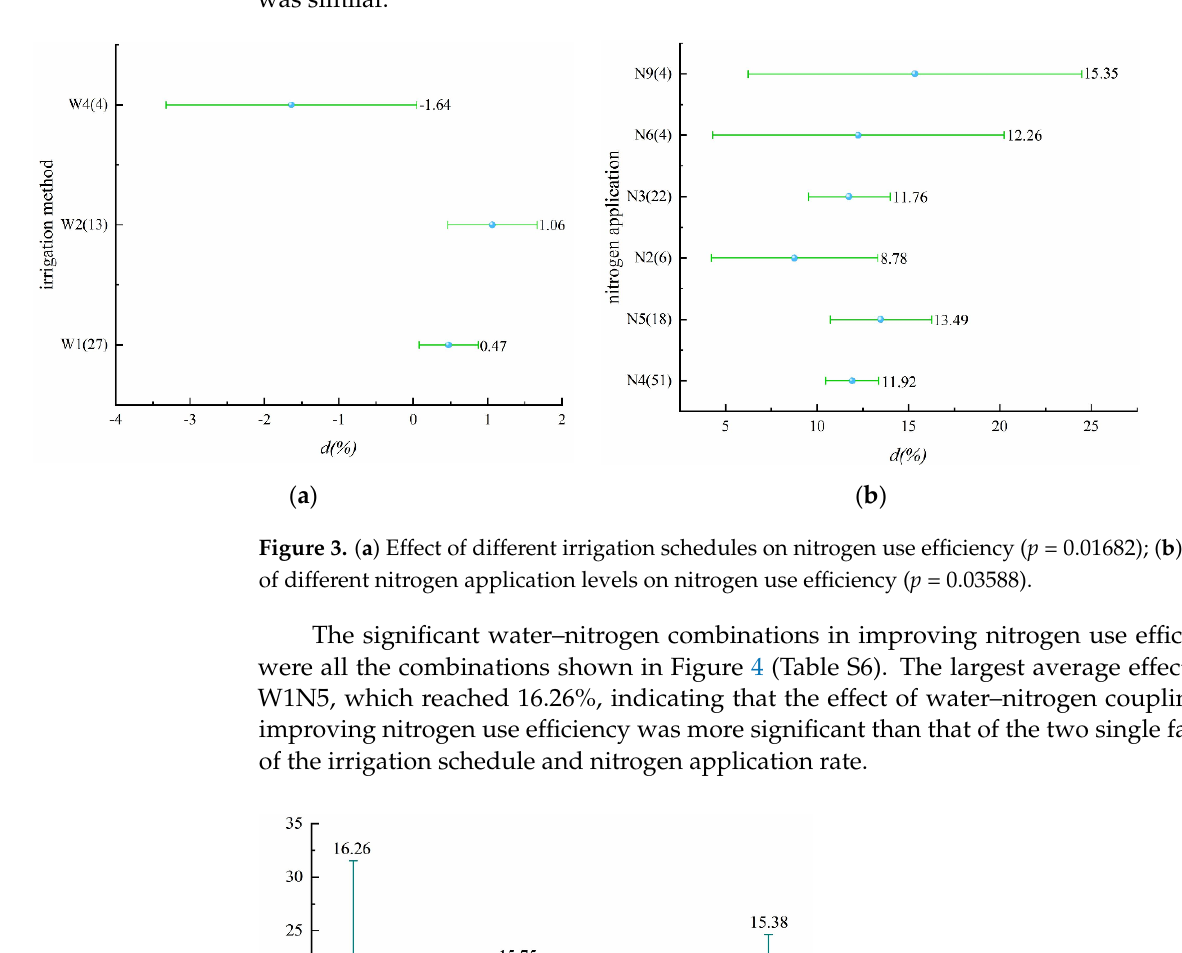
Figure 4. Effect of different water – nitrogen combinations on nitrogen use efficiency ( p = 0.01631).